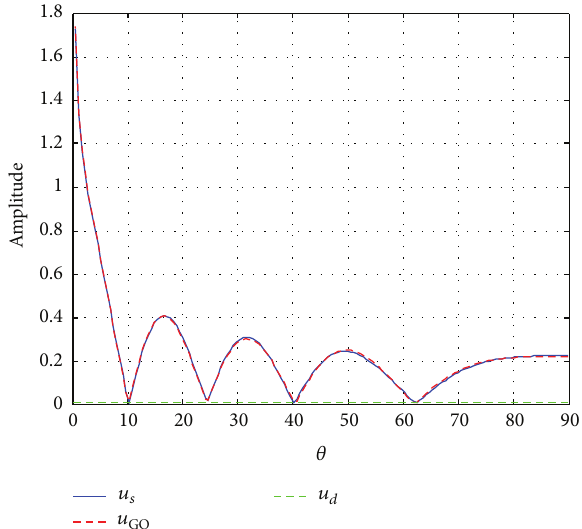
Figure 5: Scattered represented by 𝑢 𝑠 , geometric optics represented , and diffracted represented by 𝑢 𝑑 fields. The observation by 𝑢 GO distance 𝑟 is 3𝜆 and the aperture size 𝑎 is 10𝜆